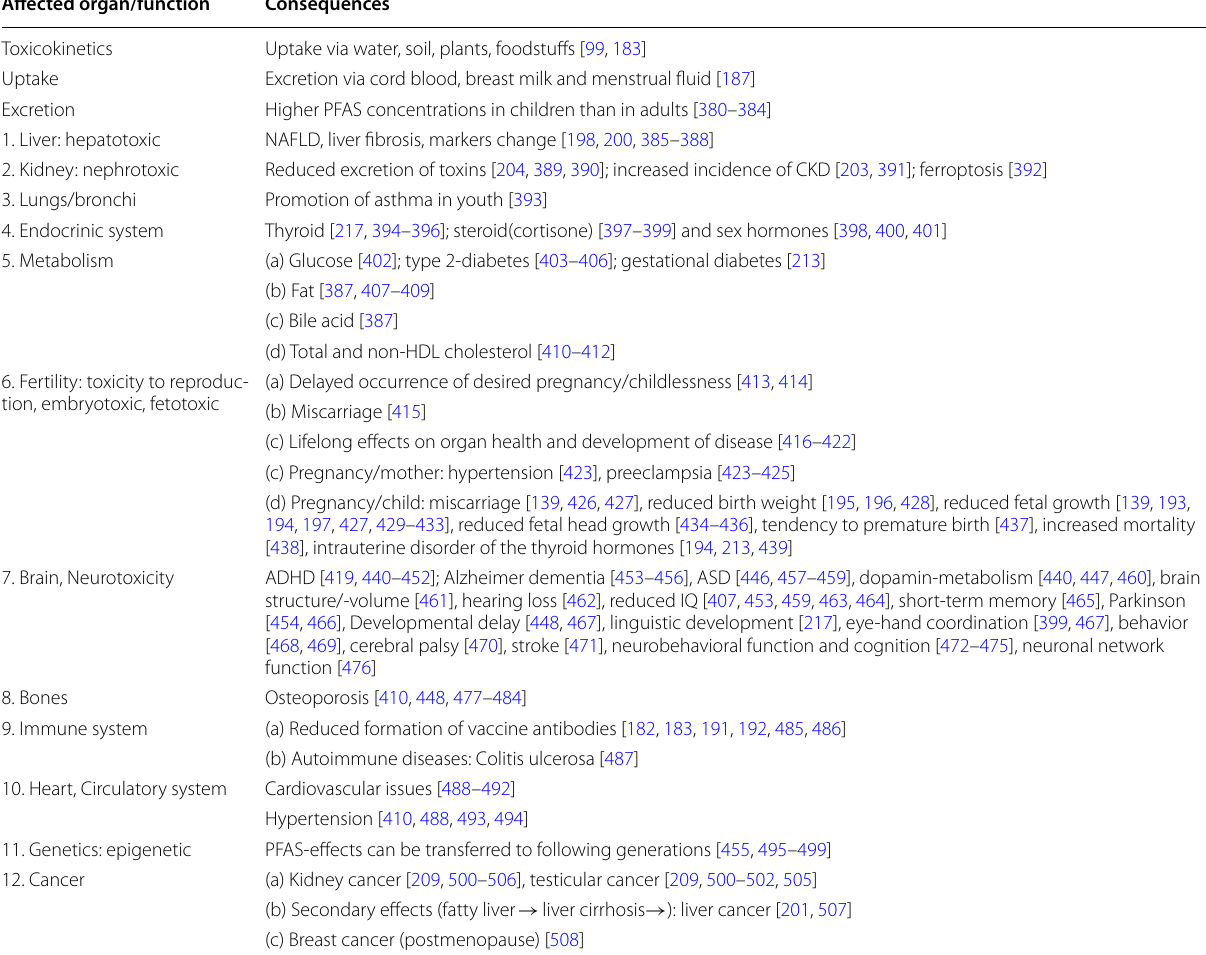
Table 2 Toxicological results on